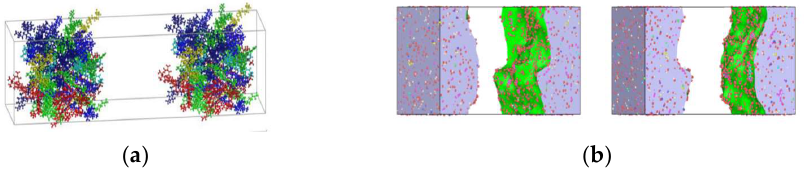
Figure 5. ( a ) The initial model of self-healing of asphalt binder with artificial insertion of vacuum zone. Adapted with permission from [24]. Copyright 2020 Elsevier; ( b ) The initial model of self-healing of asphalt binder selected in this paper.